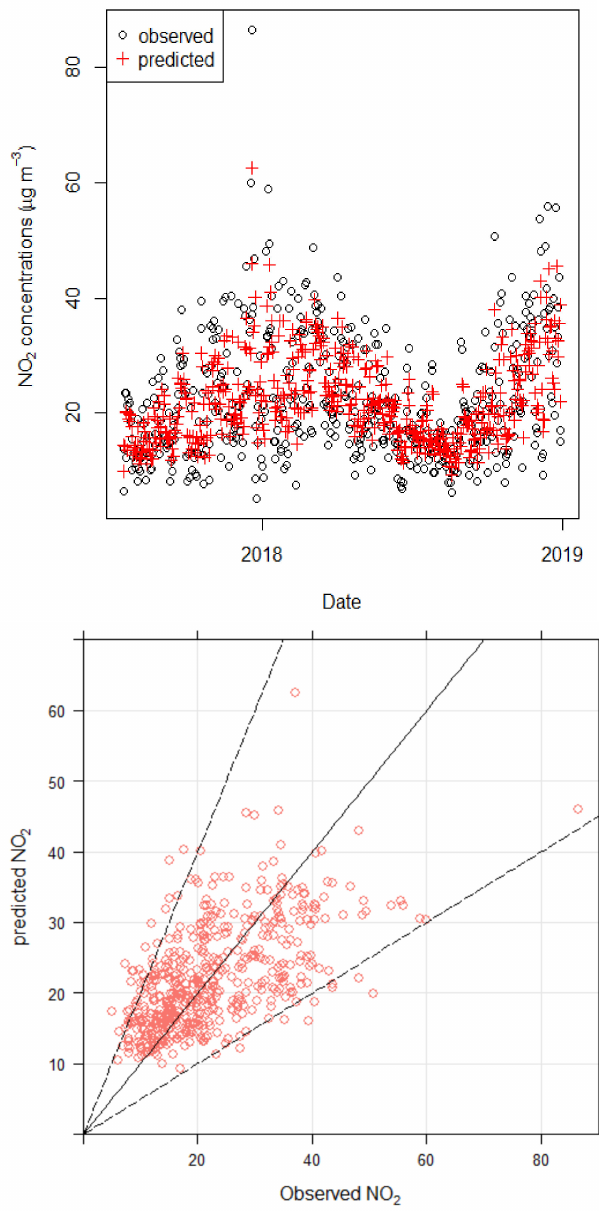
Figure 15. Predicted vs. observed daily average NO 2 concentrations ( µ g/m 3 ) using the ARIMA (1,1,1) model. Model performance was assessed against held-out testing data, which was not used for model fitting. No exogenous variable was used in the model. The solid line represents the 1:1 relationship, whereas the dashed lines represent the 1:0.5 and 1:2 relationships, between observed and predicted concentrations. The dashed lines show the points that are within a factor of two